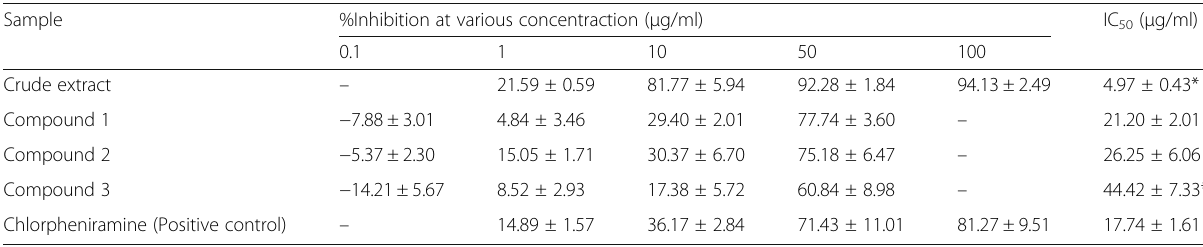
Table 1 Inhibitory effect of crude ethanolic extract and isolated compounds from Baliospermum montanum root on releasing of β -hexosaminidase from RBL-2H3 cell line